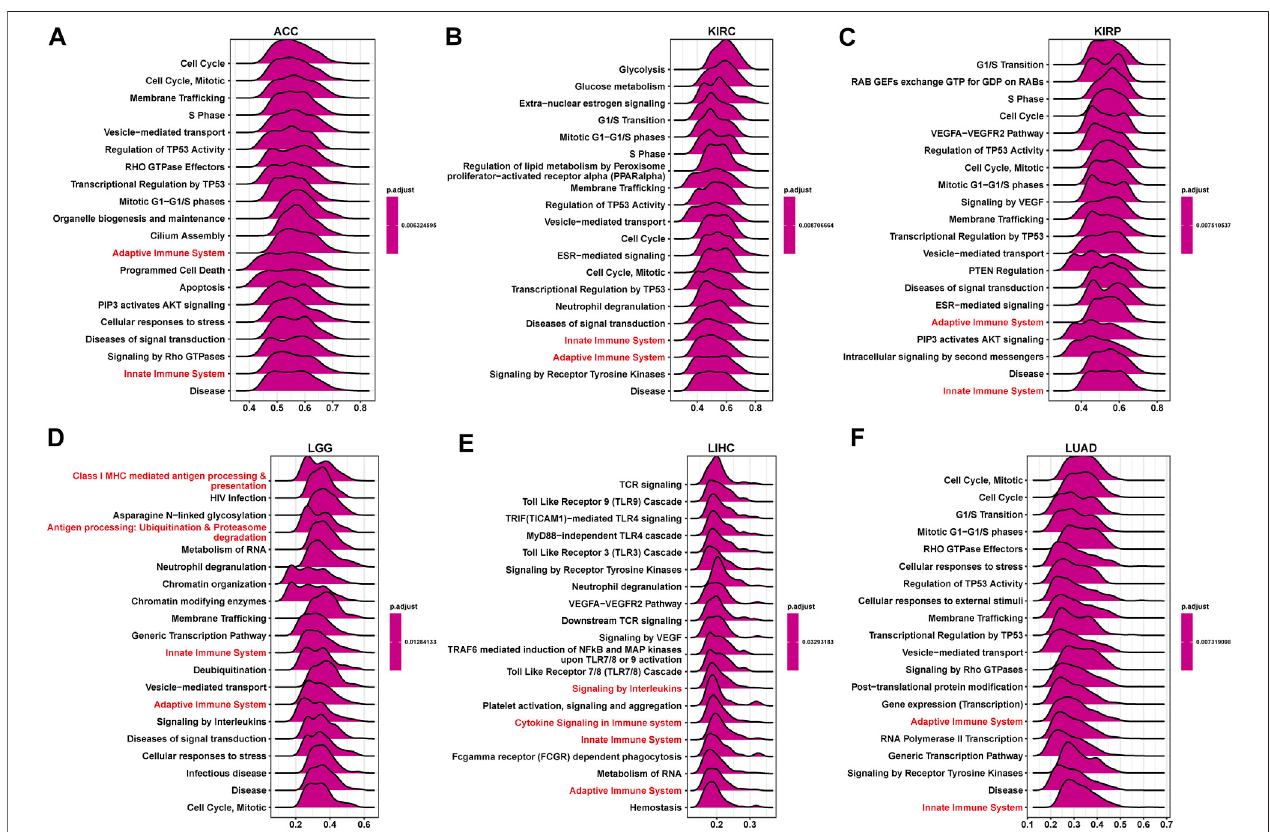
FIGURE 6 | GSEA of P4HA1 in pan-cancer. (A – F) The top GSEA results in indicated tumor types (NES ≥ 1.5, adjusted p -value < 0.05). Red indicates immune regulation-related pathways.